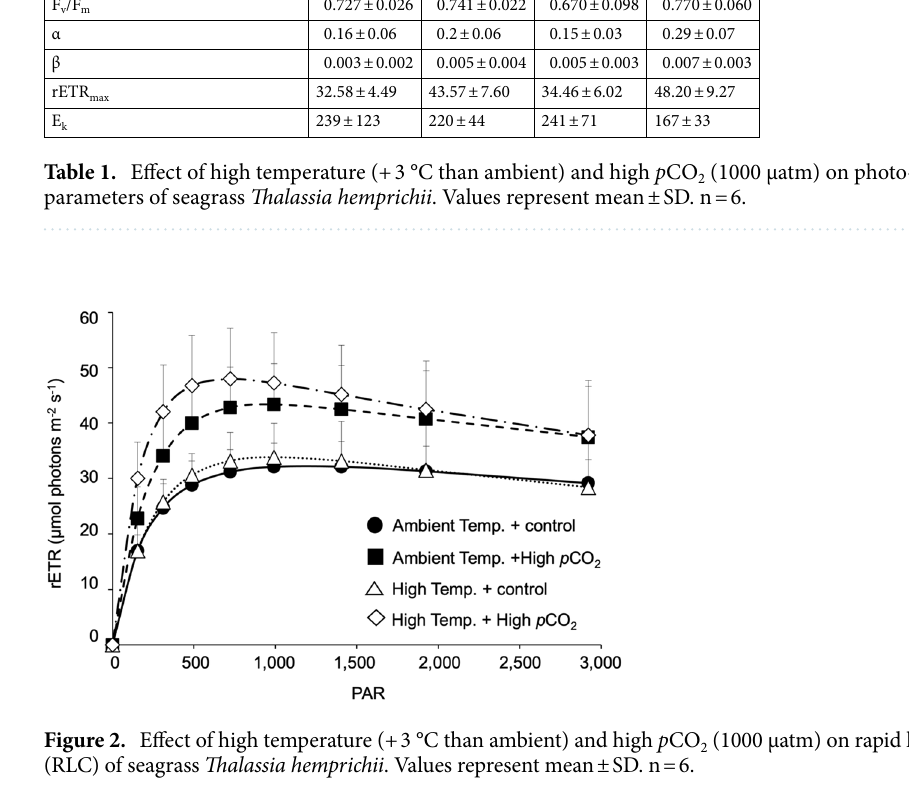
Photo-physiological parameters